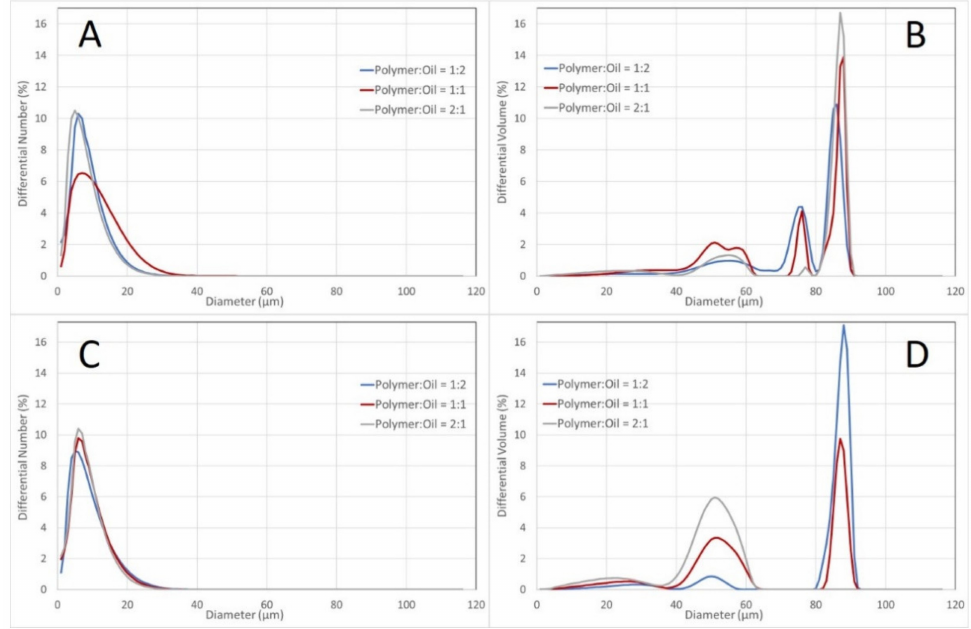
Figure 4. Size distribution of peppermint oil complex coacervate microcapsules with different Polymer:Oil ratios before ( A , B ) and after ( C , D ) spray drying as measured using laser diffraction. Crosslinker concentration = 5% ( w : w ) with respect to BSA for all